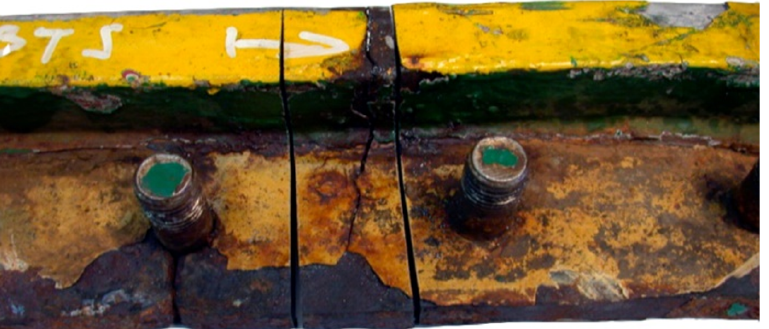
Figure 39. Crack II running through a bolt hole (handy-size bulk carrier 30185 DWT). Macroscopic ex- amination.